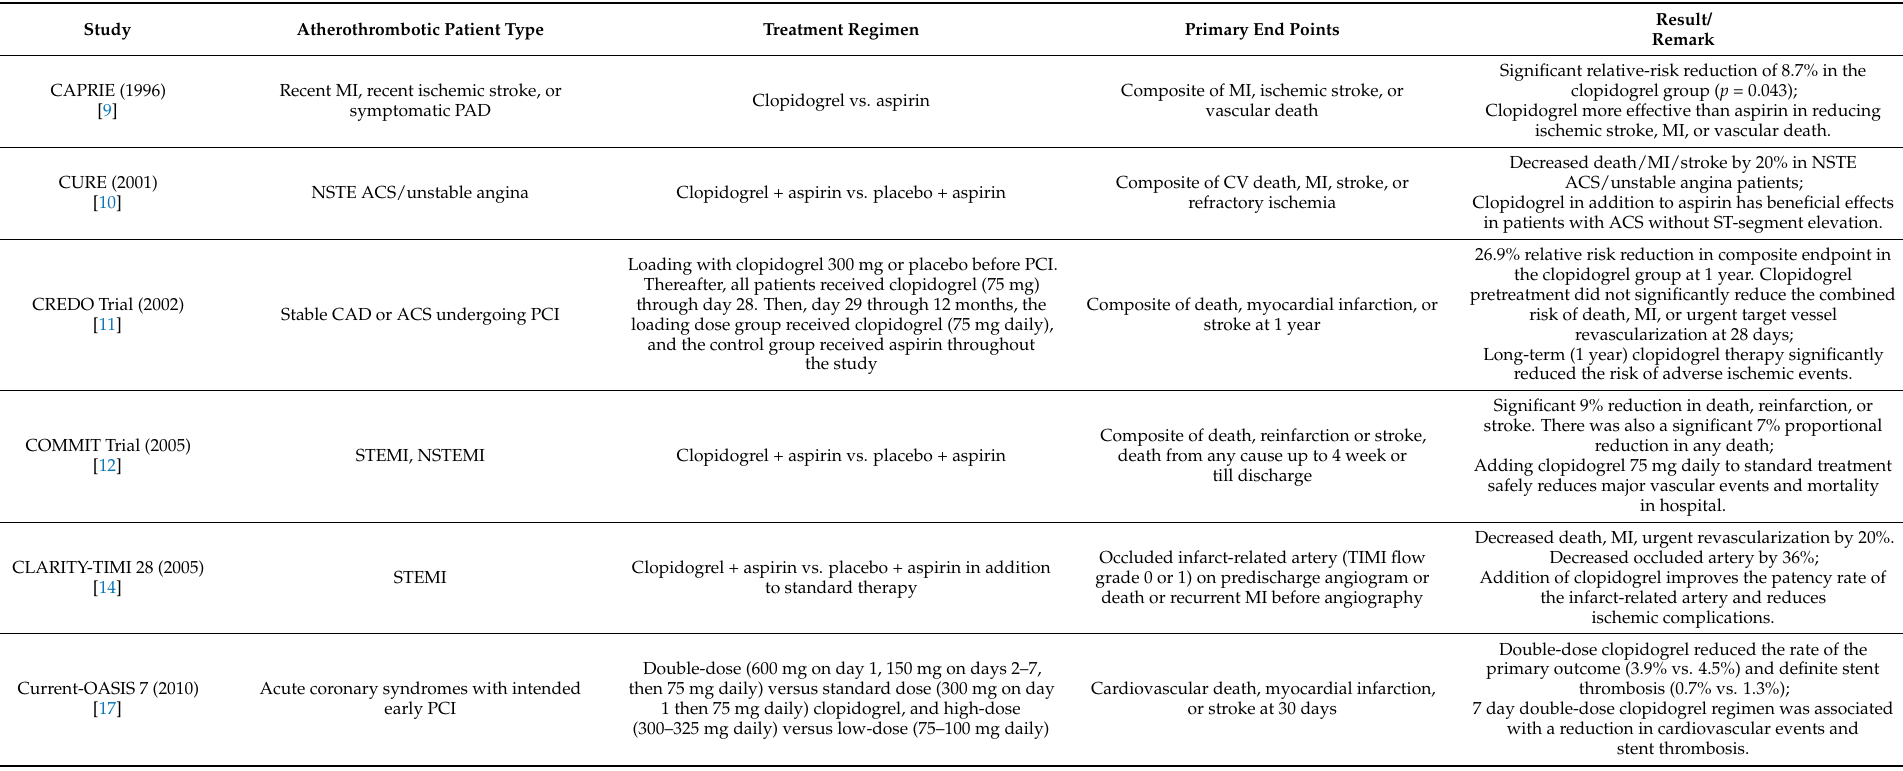
Table 1. The 6Cs of clopidogrel